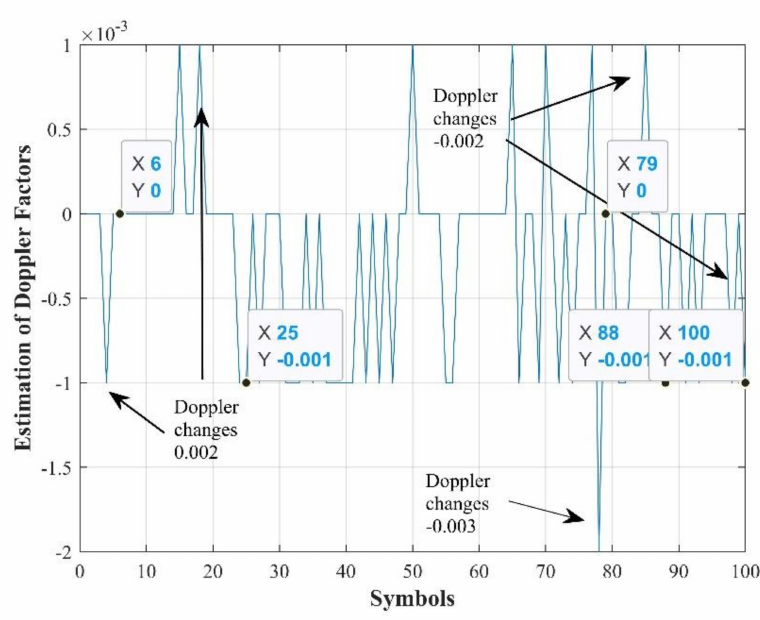
Figure 18. The 9th data packet Doppler